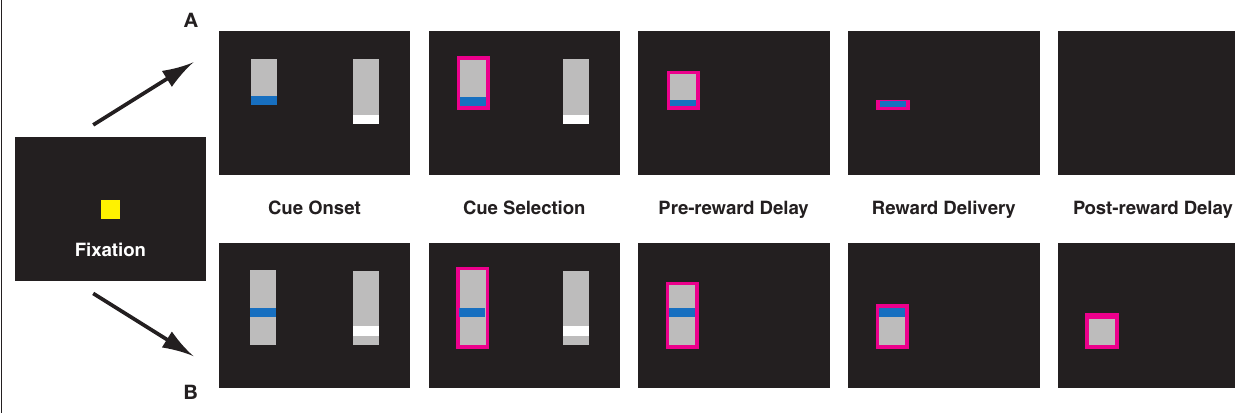
Figure 1 | Task design for the uncued (A) and cued (B) variants of the inter-temporal choice task. In the cued version of the task, pairs of targets appeared after a brief fixation period. In a third variant, monkeys had to maintain fixation to shrink the bar. Lengths of vertical bars represented delays to reward, colored stripes differing juice volumes. Monkeys were required to briefly hold fixation on the target of their choice (0.5 s), after which the